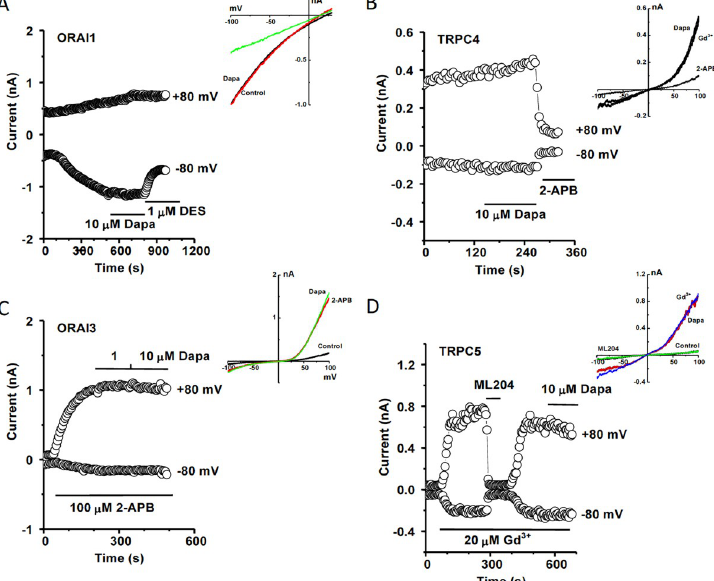
Fig 8. No effect of dapagliflozin on ORAI1, ORAI3, TRPC4 and TRPC5 currents. Whole-cell patch recording was performed using HEK293 T-REx cells overexpressing ORAI or TRPC channels. The detail procedures are similar to our previous reports [13,27–29].A, Example of ORAI1 current recorded in the HEK293 T-REx cells expressing ORAI1-mCherry. The current was induced by thapsigargin (1 μ M) in the pipette solution. Dapagliflozin (Dapa) showed no obvious effect on the current, but diethylstilbestrol (DES) as a positive control blocker significantly inhibited the ORAI1 current. B, Example of ORAI3 current induced by 2-APB (100 μ M) and the effect of Dapa (1, 10 μ M). C, Example of TRPC4 current in the presence of activator Gd 3+ (20 μ M) and the effect of Dapa (10 μ M). 2-APB (100 μ M) was added as a positive control (inhibitor). D, TRPC5 was induced by Gd 3+ (20 μ M) and the effect of ML204 (10 μ M) and Dapa (10 μ M). The IV curves were shown as insets in each panel. N = 3–5 for each channel current recorded by whole-cell